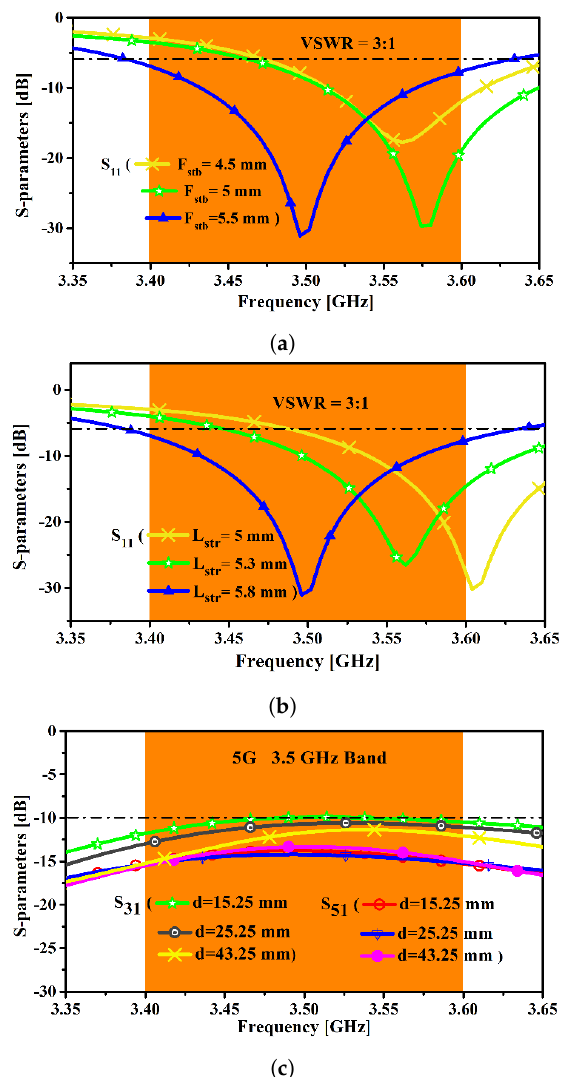
Figure 4. The simulated S-parameter as a function of ( a ) F stb , ( b ) L str , and ( c )